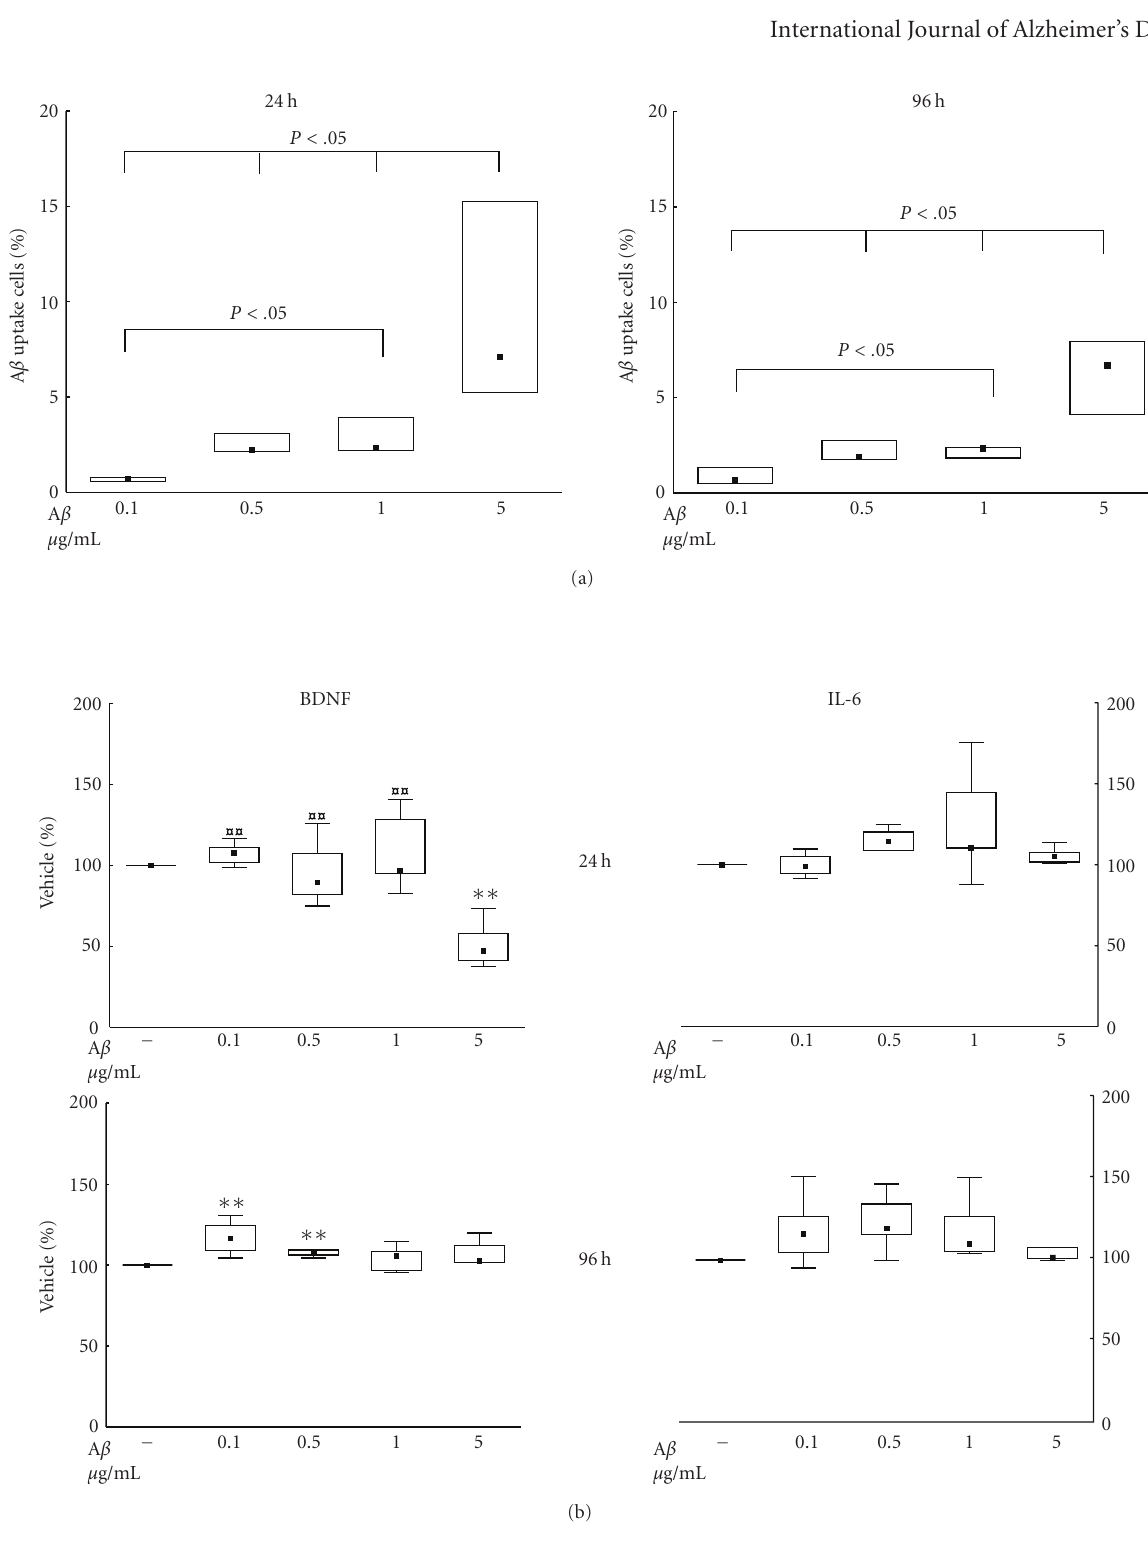
Figure 3: (a)-(b) Uptake of A β 1 – 42 (a) and the concurrent secretion of interleukin-6 (IL-6) and brain-derived neurotrophic factor (BDNF) (b) by human CHME3 microglial cells at 24 and 96 hours. The cells were incubated with concentrations of A β 1 – 42 , ranging between 0.1 and 5 μ g/mL, or vehicle. The cells were harvested and the medium collected at 24 and 96 hours. In (a), the data are expressed as the proportion of cells with intracellular A β 1 – 42 , n = 4. In (b), the data are expressed as % of control (vehicle) set at 100% and shown as median ± percentiles (25%–75% and 10%–90%). There was a significant e ff ect of the treatment on the uptake of A β 1 – 42 at 24 hours ( P = . 0045) and at 96 hours ( P = . 0375). The secretion of BDNF was also significantly altered by the treatment at 24 hours ( P = . 0102) and at 96 hours ( P = . 0375). Statistical di ff erence from A β 1 – 42 , 5 μ g/mL, is indicated by ( P < . 01); statistical di ff erence from vehicle is indicated by ∗∗ ( P < .